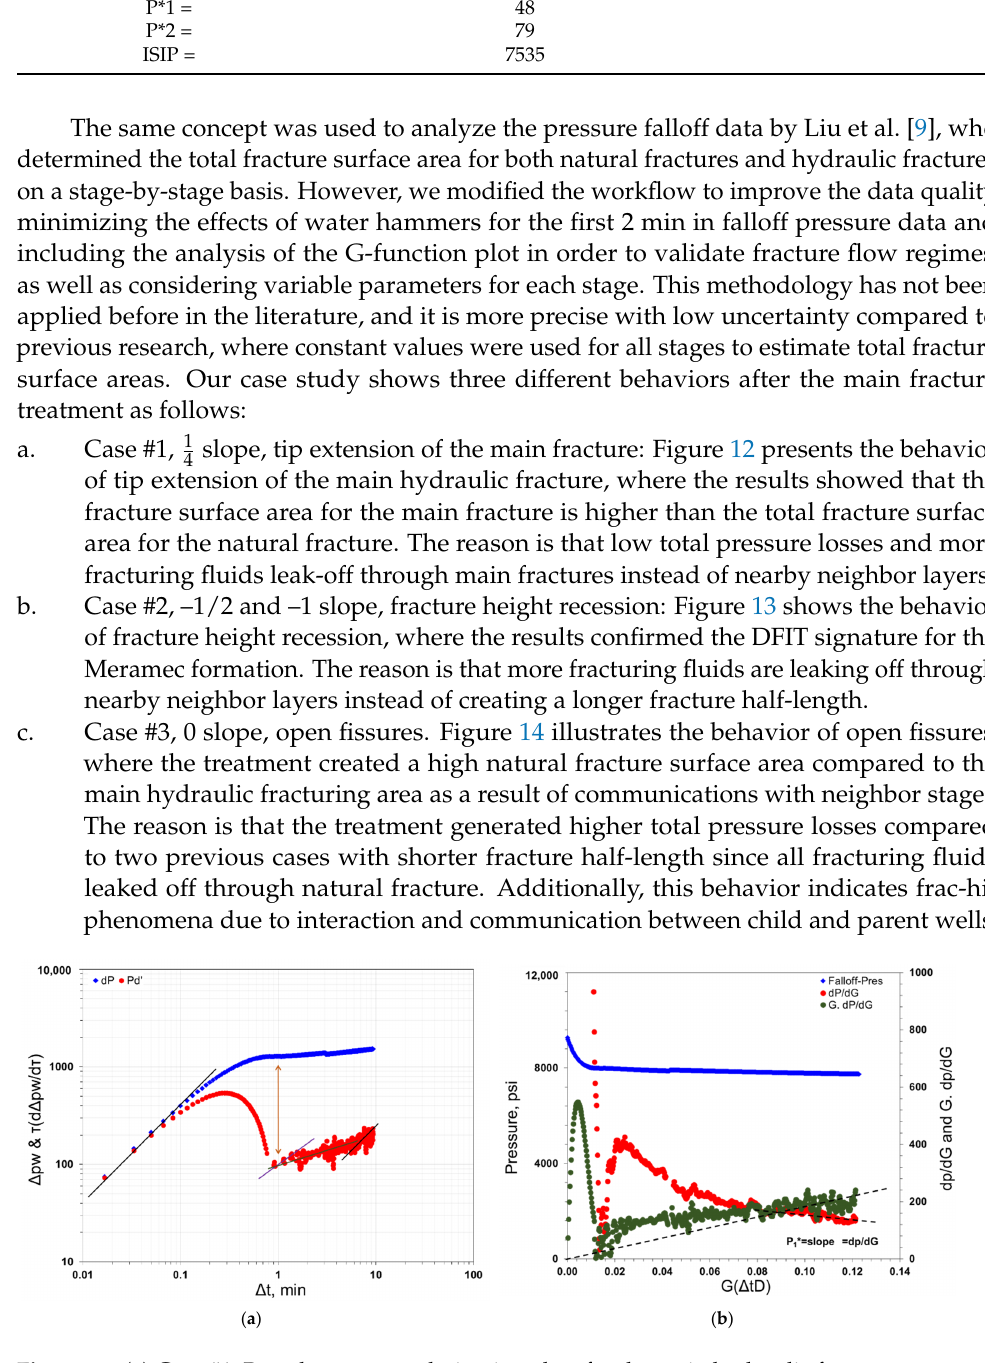
( b ) Figure 13. (a) Case #2, Bourdet pressure derivative plots for the main hydraulic fracture treatment for W2. (b) Case #2, G- function plots for the main hydraulic fracture treatment for W2.